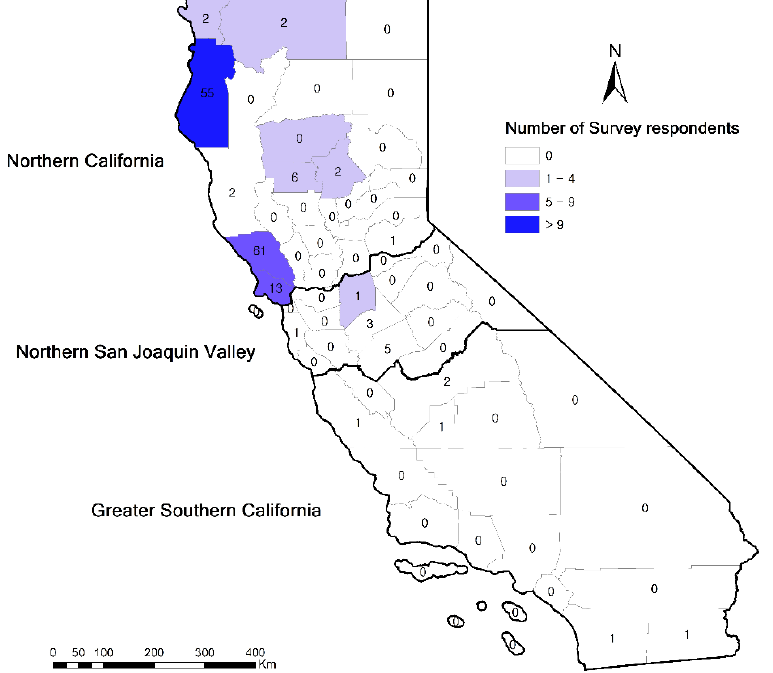
Figure 1. Map showing the number of organic farms and survey respondents in each county and the boundaries of the three CA regions. The numbers indicate the number of invited organic farms, and the colors indicate the number of survey respondents (n = 31 farms, 5 farms did not specify their county). This map was generated using ArcGIS (Environmental Systems Research Institute (ESRI), ArcGIS Release10.8.1, Redlands, CA, USA).